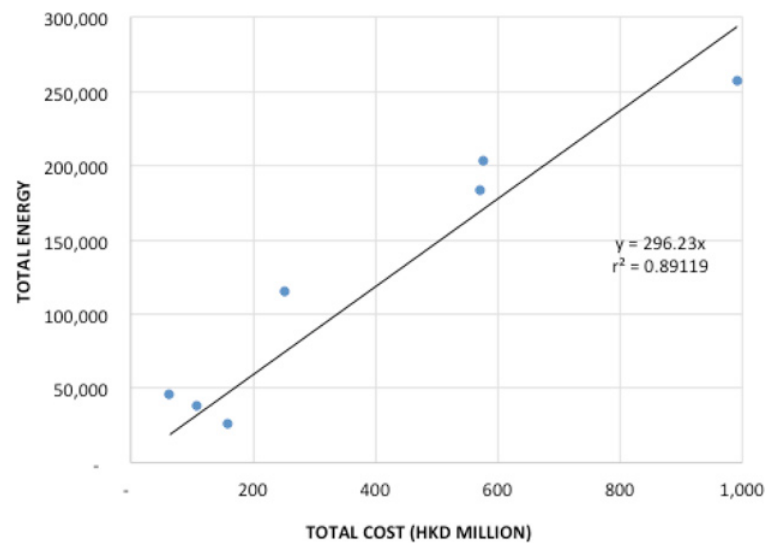
Figure 3 Refurbished EE versus Cost (Hong